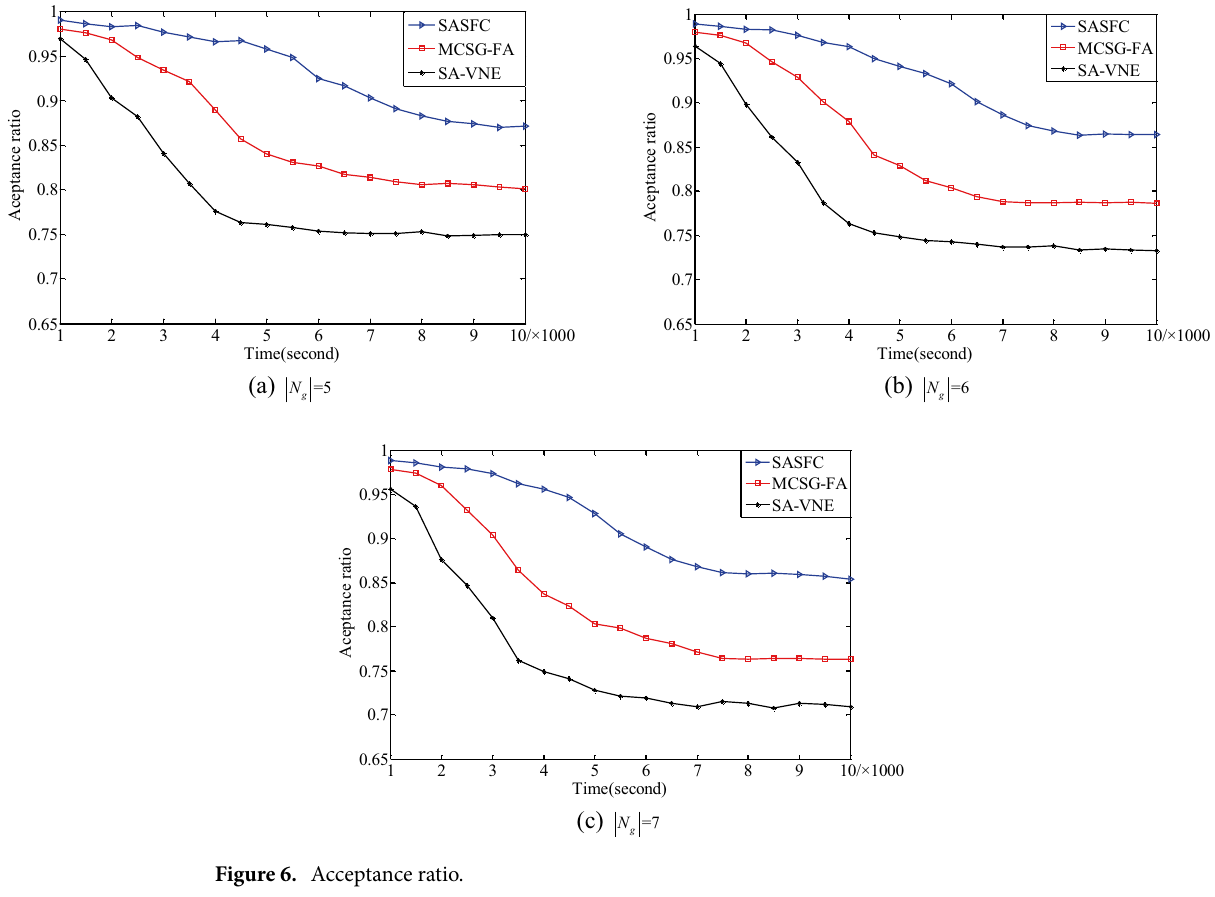
Figure 6. Acceptance